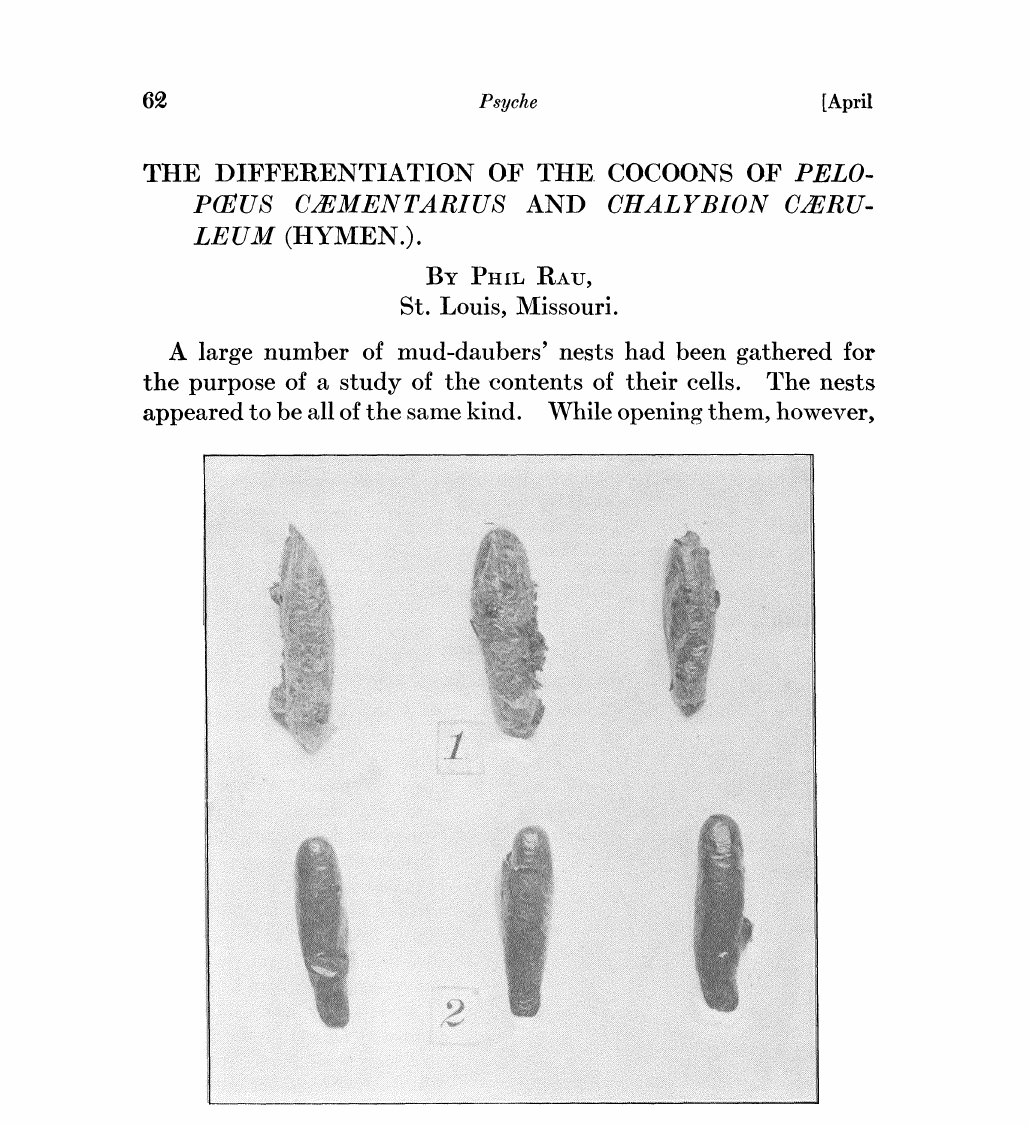
Fig. 1. 1, Cocoons of Chalybion cruleum; we were for a time puzzled by a variation in the structure of the